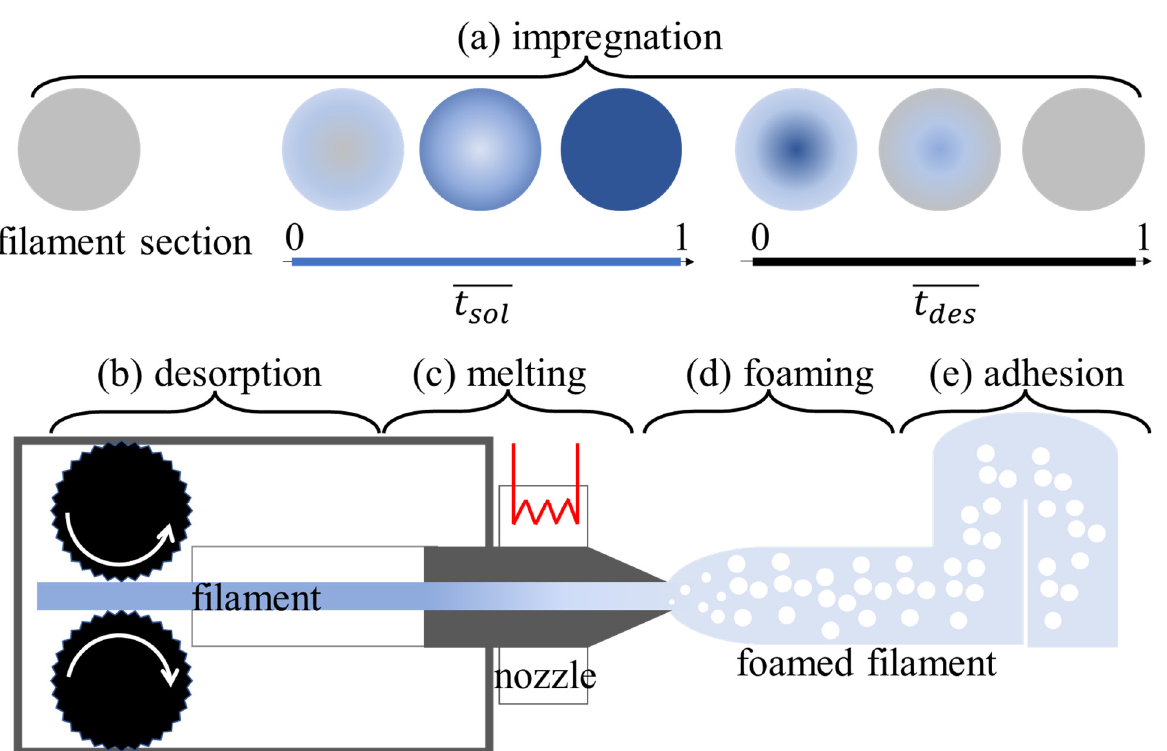
Figure 1. Schematic representation of the 5 steps to print foamed strands: ( a ) impregnation, ( b ) de- sorption, ( c ) melting, ( d ) foaming and ( e ) adhesion among the strands. orption, ( c ) melting, ( d ) foaming and ( e ) adhesion among the